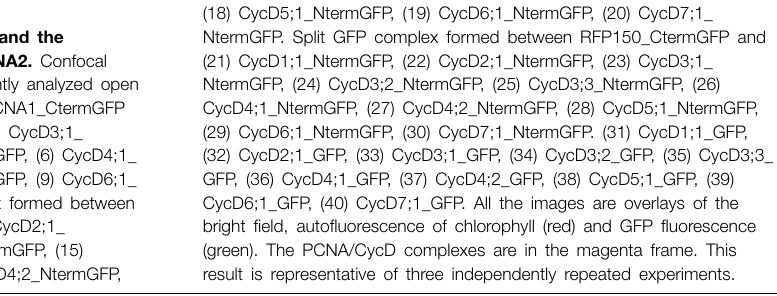
FIGURE 2 | Continued Analysis of D-type cyclins subcellular localization and the formation of complexes with either PCNA1 or PCNA2. Confocal images of N. benthamiana leaf cells expressing transiently analyzed open reading frames. Split GFP complex formed between PCNA1_CtermGFP and (1) CycD1;1_NtermGFP, (2) CycD2;1_NtermGFP, (3)